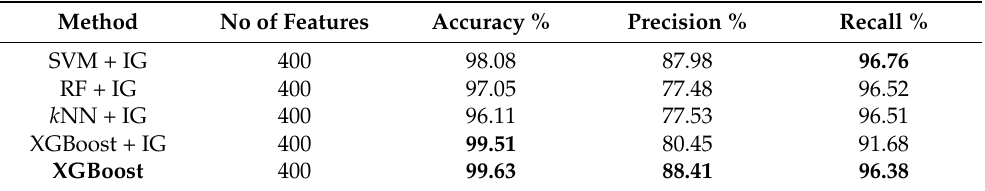
Table 2. Comparison of classification results for Data1.